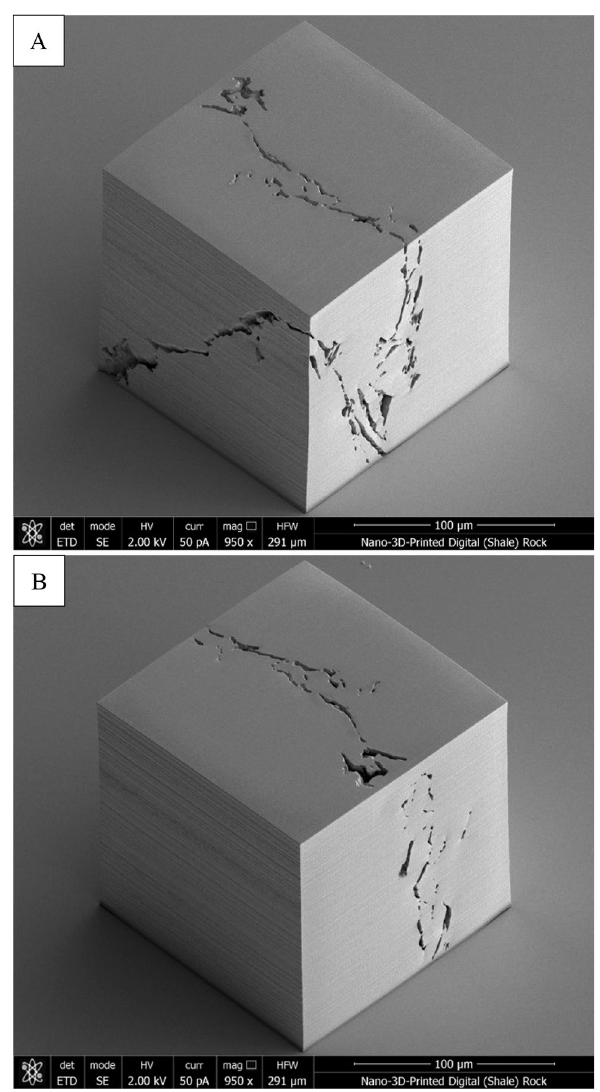
Figure 8. Scanning electron microscopy (SEM) image of the ( A ) front and ( B ) back of the 150 µm × 150 µm × 150 µm nano-3D-printed digital (shale) rock 3D